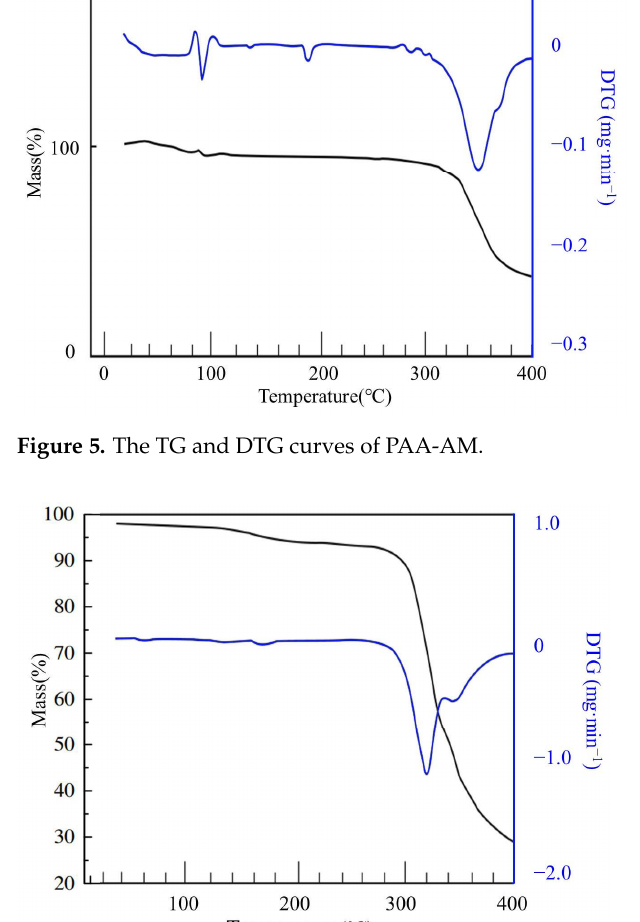
Figure 6. The TG and DTG curves of PAA-AM/St.